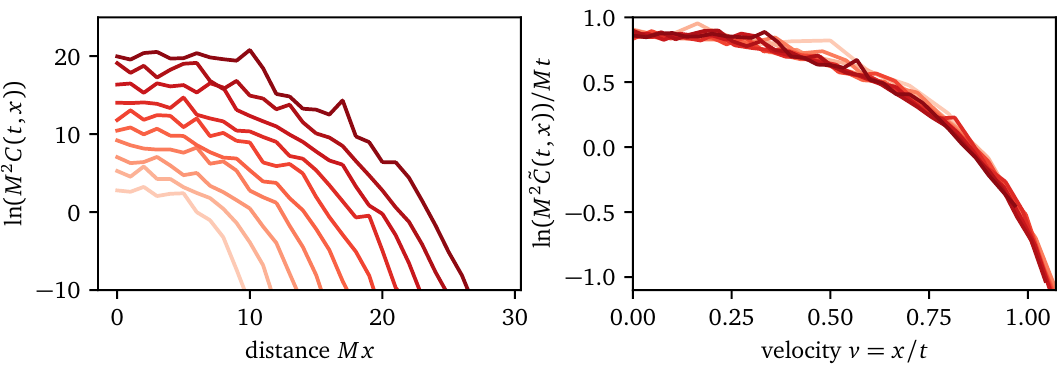
Figure 5: Scaling collapse of the OTOC. On the left we display equally spaced time slices in the interval M t [ 10,30 ] for G = 61.44 along one spatial axis, with times ∈ increasing from bright to dark colours. The collapse in the right plot indicates that C ( t , x ) exp ( λ ( v ) t ) , with a scaling function λ ( v ) = λ ( x / t ) . The OTOC C ( t , x ) 0 ∼ → outside the causal lightcone v / c = 1 in the limit a 0, which we checked numeri- s → cally. We plot ˜ C ( t , x ) = C ( t , x ) const., where the constant is the intersection with − the y-axis of the linear fit to ln ( C ( t , x = 0 )) for M t >